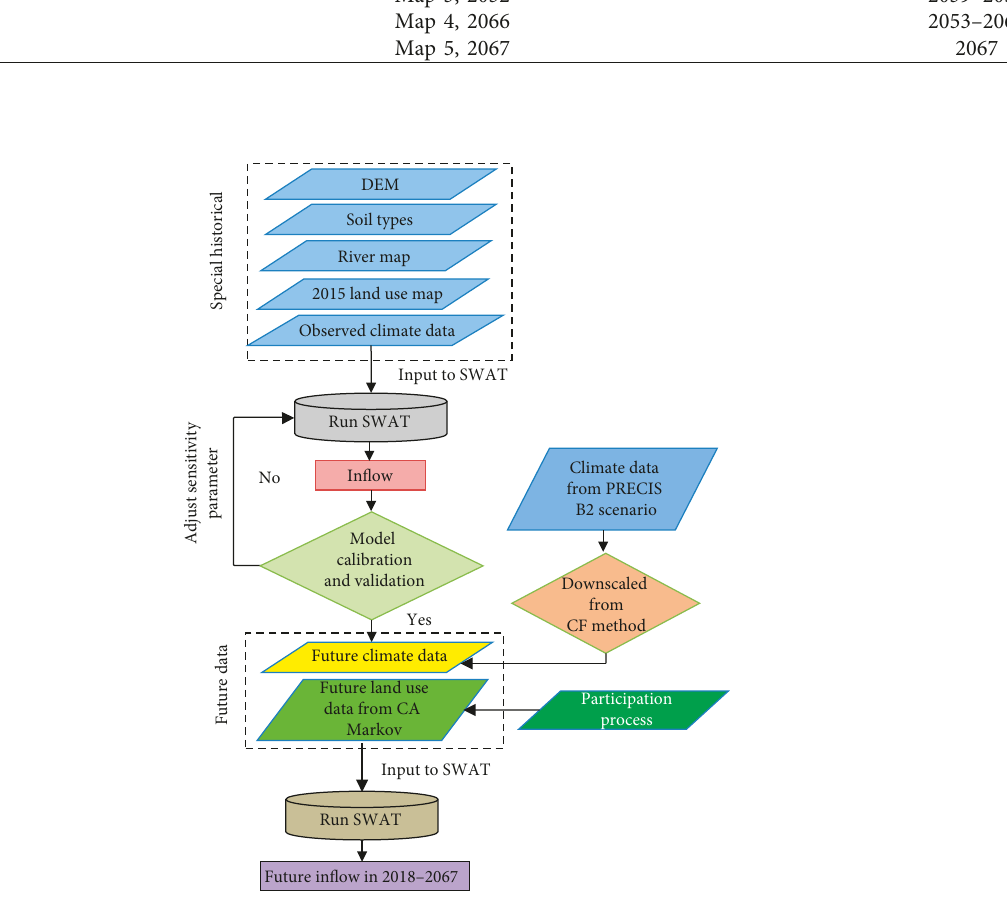
Figure 4: Study schematic of calculation steps for future inflow forecasting. Table 3: The validation results of maps simulated by CA Markov. Area R 2 Hauy Sabag reservoir